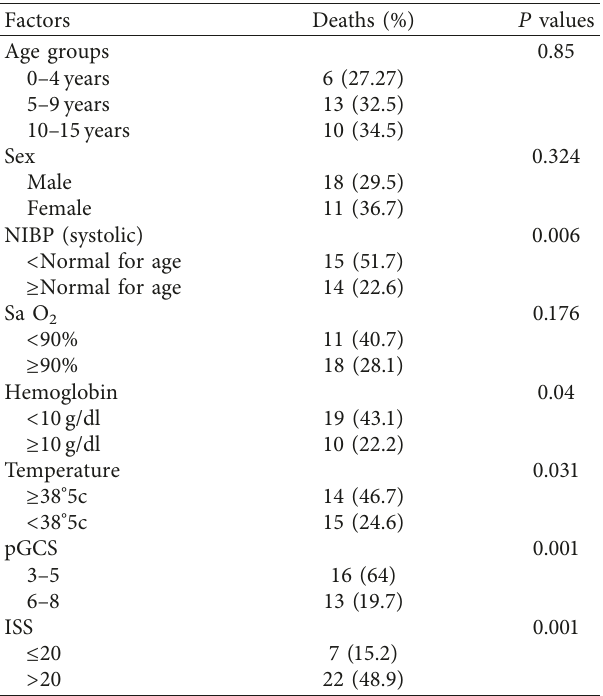
Table 3: Factors associated with pediatric traumatic brain injury mortality.